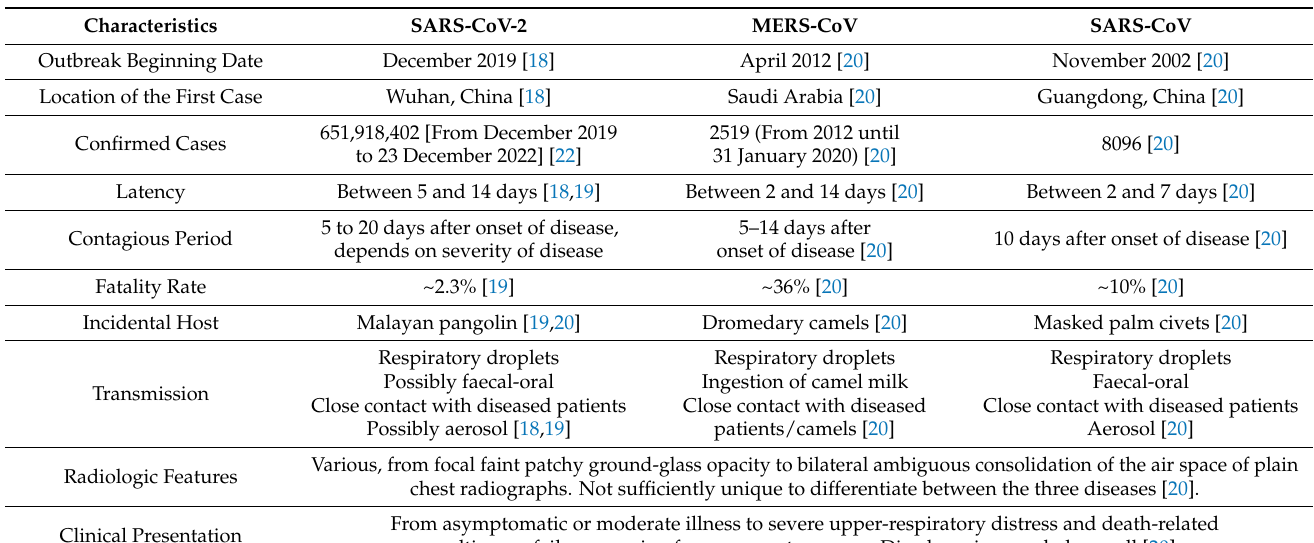
Table 1. Comparison of the epidemiological, clinical, and radiological characteristics of SARS-CoV, MERS-CoV and SARS-CoV-2